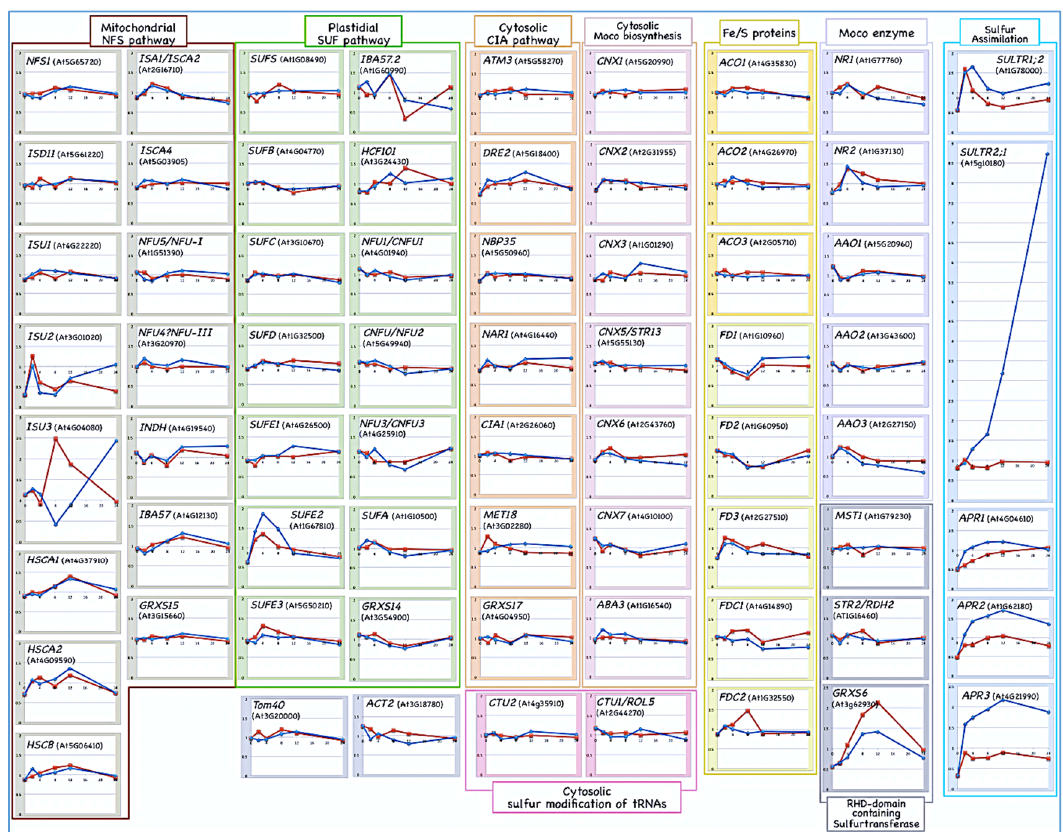
Figure 4. Arabidopsis plants of 10-day-old grown on sulfate-containing medium were transferred to the medium with (the same concentration of) or without sulfate, and time course values of the transcripts were monitored for 24 h after sulfate repletion or depletion from the medium. Transcript levels of the genes related to the mitochondrial NFS, plastidial SUF, and cytosolic CIA pathways for Fe / S cluster biosynthesis and to some Fe / S proteins (aconitases and ferredoxins) are indicated. Gene expression levels of the transcripts of the cytosolic sulfur transfer pathways for Moco biosynthesis and sulfur modification of tRNAs also shown. Gene expression levels for some Moco-enzymes (two nitrate reductases NR1 and NR2 , and three aldehyde oxidases AAO1, AAO2, and AAO3 ), some RHD-domain containing proteins such as mercaptopyruvate sulfurtransferases ( MST1 and STR2 / RDH2 ) and a cytosolic glutaredoxin, GRXS6 , are also indicated. Transcript levels of several SULTR s and ARP s all of which are involved in the sulfur assimilation process are indicated as the highly responsive ones to the sulfate depletion [80]. Transcript levels of both TOM40 and ACT2 are also indicated because they are not related to the sulfur transfer systems mentioned here. All the microarray data used here are described in the previous paper [80]. Transcript levels were analyzed in sulfur-repleted (red line) or in sulfated-depleted (blue line) conditions. For each gene investigated here, gene name, and AGI code numbers are indicated on the top of the